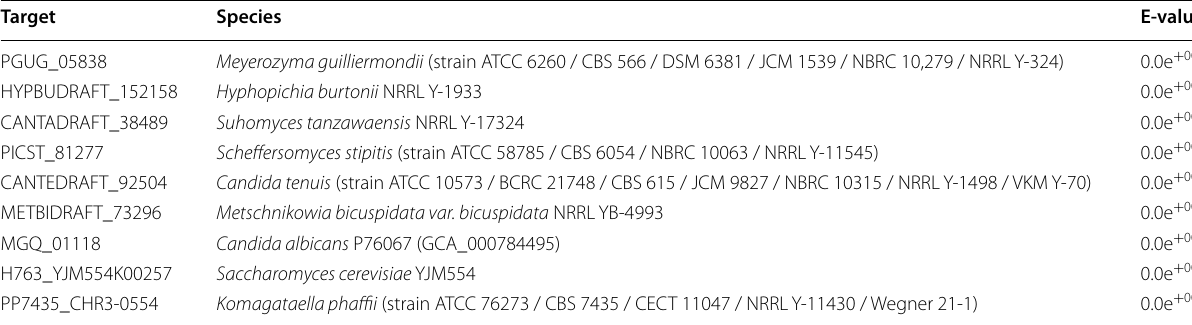
Table 4 HMM homologs hits on M. guilliermondii strain SO phospholipase D Target